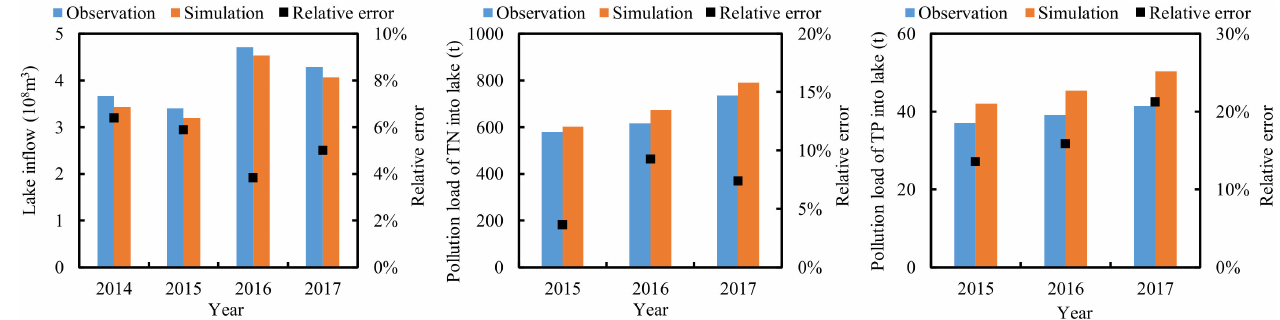
Figure 7. Comparison between simulated and observed values of lake inflow and pollution load in Lake Erhai